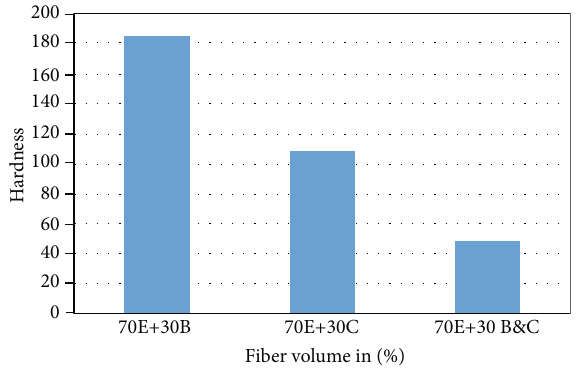
Figure 7: Hardness vs. fi ber volume in %.